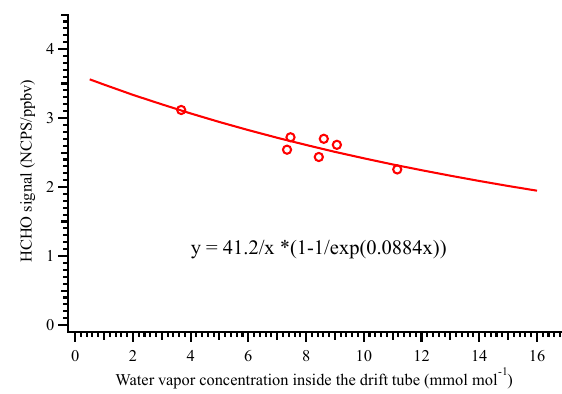
Figure 3. The response of the PTR-ID-CIMS to HCHO stan- dards (in the units of countss − 1 ppbv − 1 HCHO standard per mil- lion H + O ion, NCPSppbv − 1 ) as a function of water vapor con- 3 centration inside the drift tube. The correlation is in the form of y = A ( 1 − e − Bx ), deduced from Eq. (1), where A is the ratio be- x tween the forward ( k ) and reverse ( k (cid:48) ) reaction rate coefficient and B is the product of k (cid:48) and the ion–molecule reaction time t